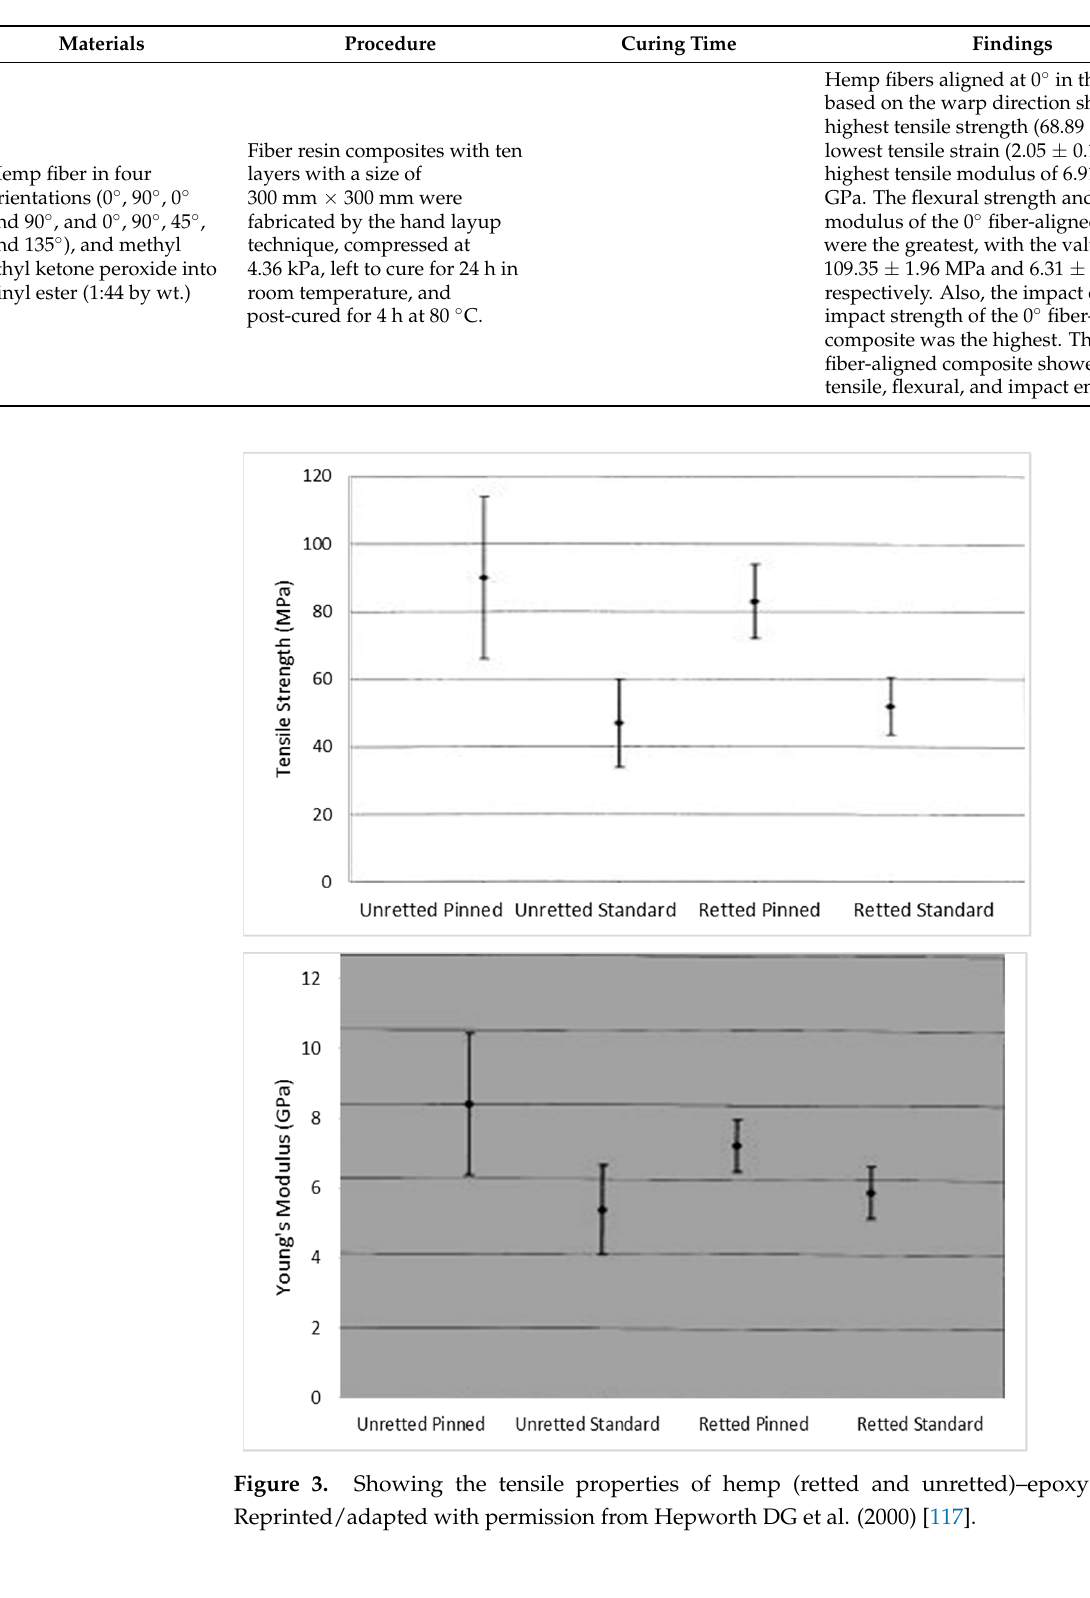
Figure 4. ( A ) Showing the difference in Young’s Modulus (in GPa) of hemp fiber against the days of harvest. ( B ) Showing the change in tensile strength (in MPa) as a function of harvest time. Reprinted/adapted with permission from Hepworth DG et al. (2000) [117]. 3. Current Issues with Hemp Composite Materials Apart from the common issues discussed above, lightweight, corrosion-resistant, and mechanically sound hemp composite materials come with cost-related challenges, including recyclability (due to the cross-linked nature of thermostat resin, inorganic fibers, and inorganic fillers). As per the Ford Motor Co. (Dearborn, MI, USA), the substitution of steel, aluminum, and plastic by composites is a challenge due to three main reasons: design optimization, simulations, and assembly [125]. The design optimization process is the most concerning one as it takes longer than that of steel, aluminum, and plastic, because there still are not enough data available on composite materials. The automotive industry has specific time windows for the design and optimization of each part, and while the parts from metal and plastics can be designed and implemented in time, a lack of robust performance data results in an inconvenient and unaffordable design cycle [126]. On the other hand, the extensive consumption of plastics in the present field of composites poses a threat to the environment due to the massive release of volatile gases during their manufacturing processes [126,127]. Once prototyping is conducted, scaleup